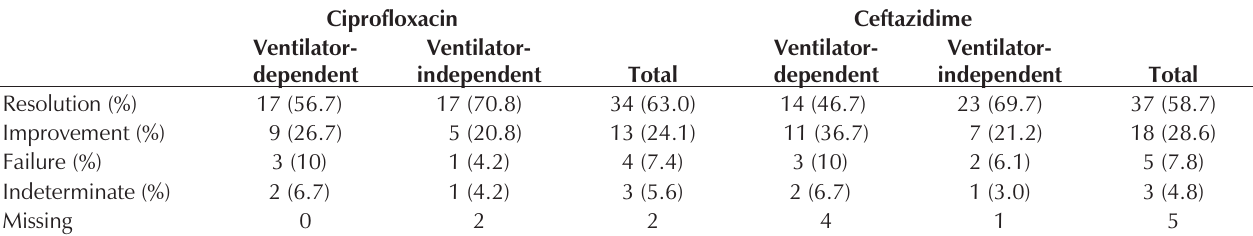
Clinical response: End of therapy